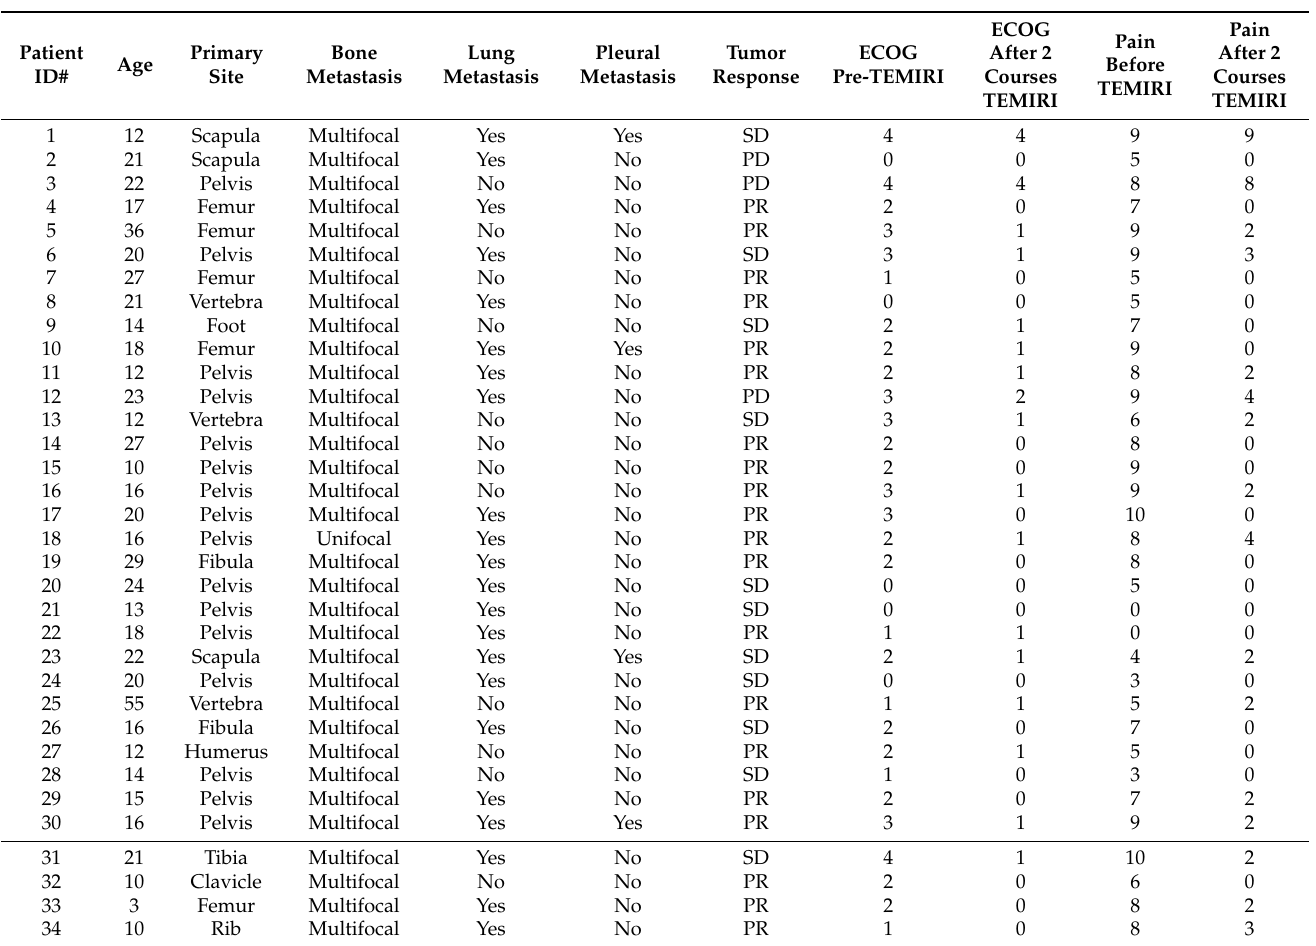
Table 3. Clinical, hematological and radiological responses to treatment. PR = Partial Response, SD = Stable Disease, PD = Progression